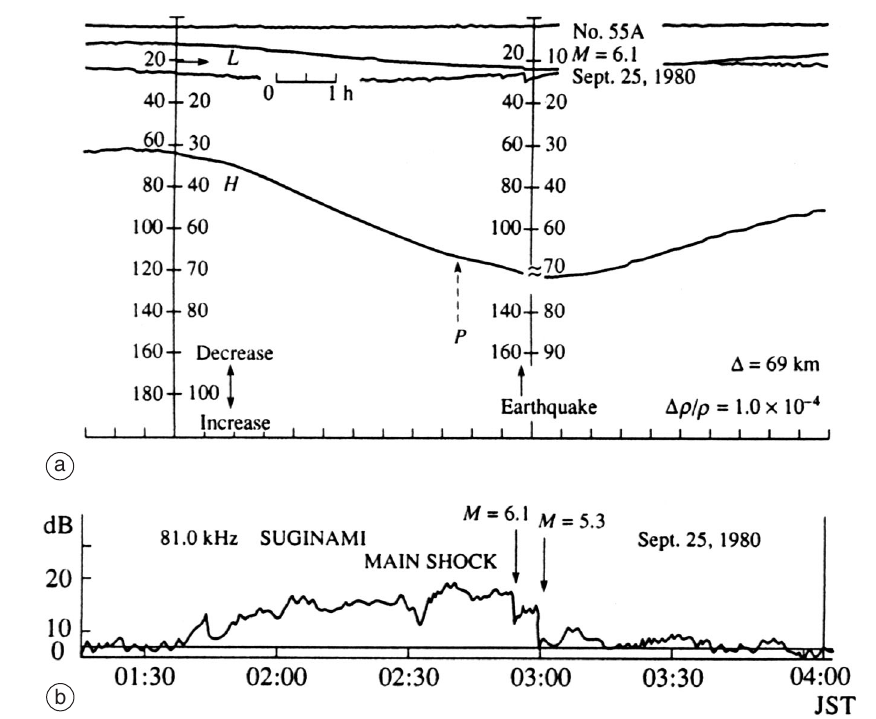
Fig. 4a,b. Synchronous development of anomalous disturbances in the variometer record of electrical resistiv- ity and EME in Japan at points 50 km apart one from the other and 70 km apart from the epicenter. a) Example of an electrical resistivity variation before an M = 6.1 earthquake (Kanto area) at the epicentral distance r e = 69 km(September 25, 1980). The symbol «P» and the dotted arrow indicate the onset of the anomaly. The solid ar- row indicates the onset moment of the earthquake. The time scale is shown in the top left corner (Yamazaki, 1983). b) EME level at a frequency of 81 kHz from observations at the Suginami seismic station near Tokyo be- fore the same earthquake (Gokhberg et al. ,